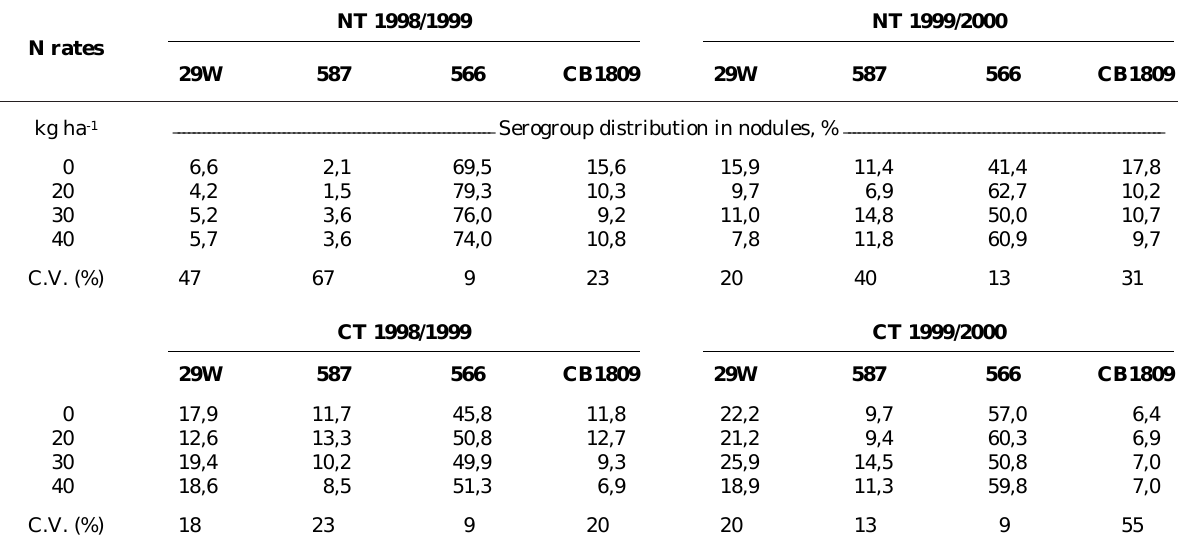
Table 4. Effects of starter N and inoculation with SEMIA 5079 and SEMIA 5080 strains on serogroup distribution of soybean nodules. Plants were grown under no-tillage (NT) and conventional tillage (CT) systems